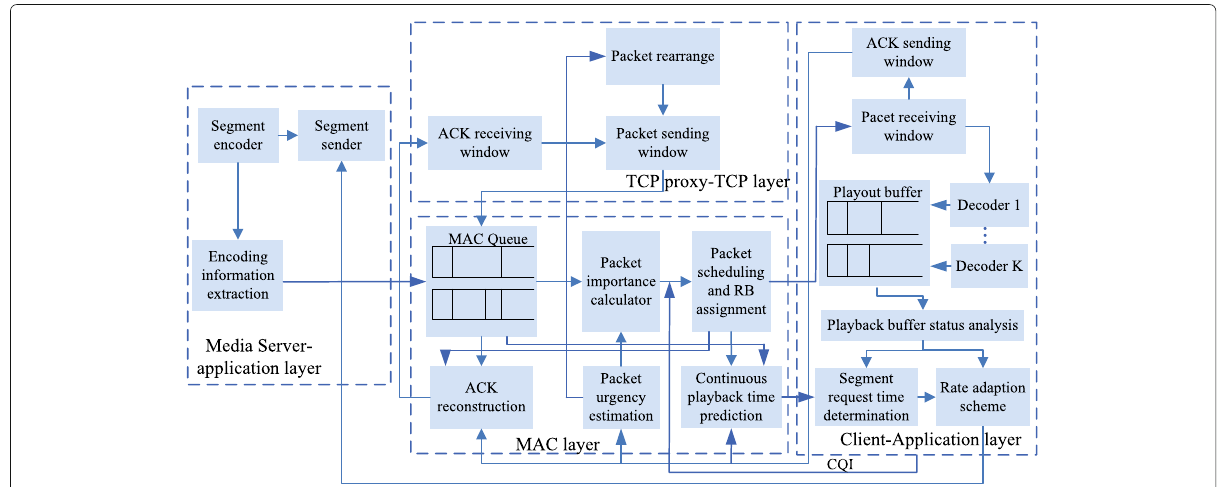
Fig. 1 The proposed system framework